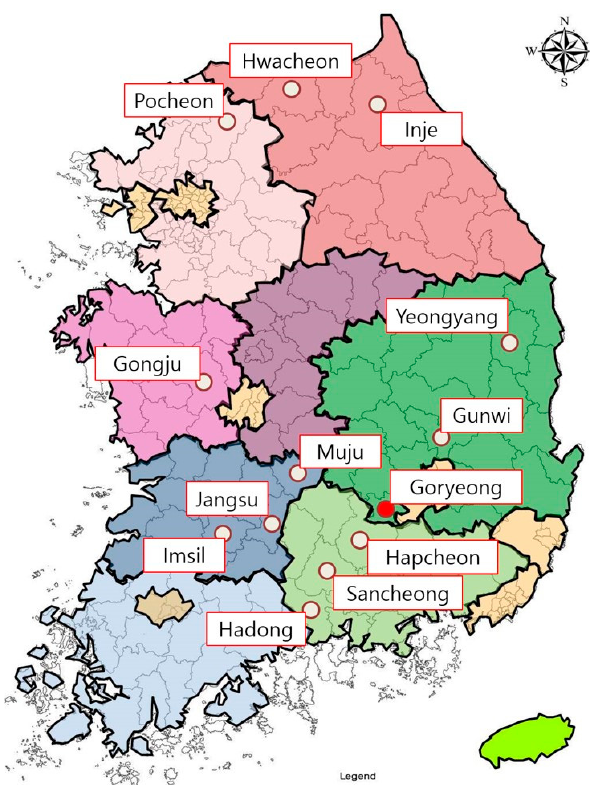
Figure 1. Bat capture sites in this study. Altogether, 241 bats were captured in 13 cities belonging to six provinces of South Korea from August to November 2021. The city in which bats with Pd were captured is marked with a red filled circle.